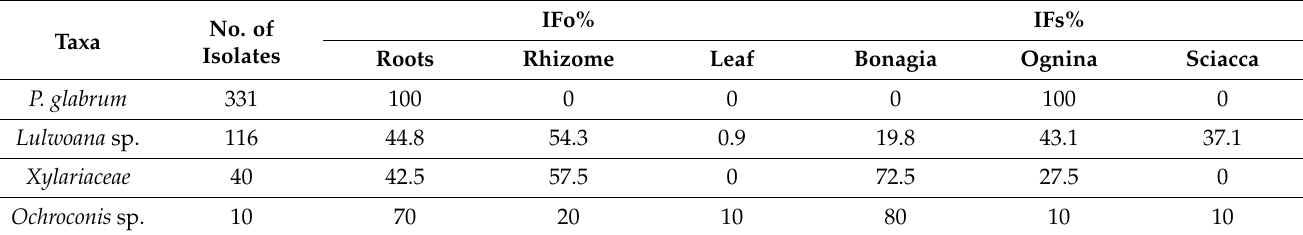
Table 3. Distribution of Lulwoana sp., Ochroconis sp., P. glabrum and Xylariaceae population, as a function of sampling site and P. oceanica organ.